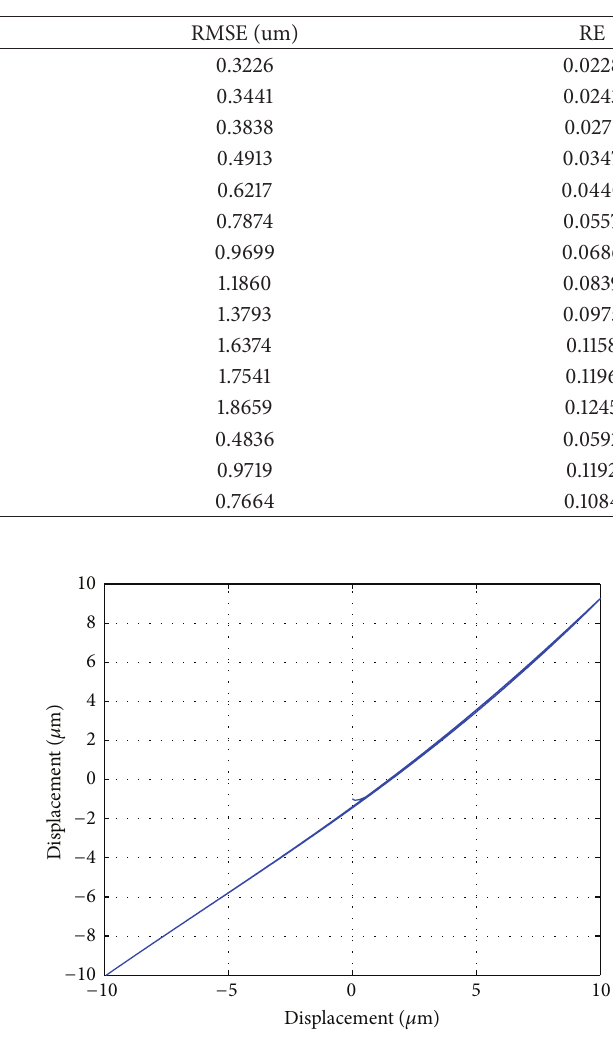
Figure 7: The compensation effect of the inverse